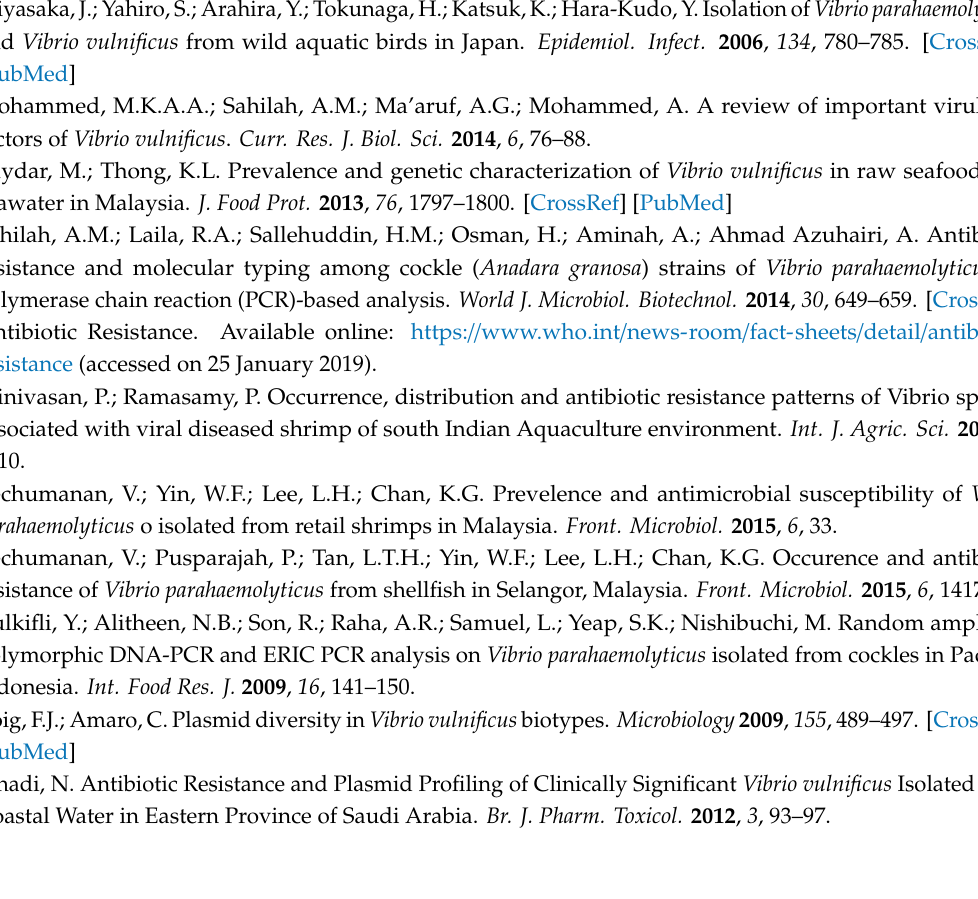
Figure S1: Plasmid identification using PureYield ™ Plasmid Miniprep System kit (Promega, USA) on 1% (w / v) agarose gel. Lane 1: Lambda. DNA-HindIII Digest DNA ladder. Lane 1-15: Vv isolates 1-15; Figure S2: Plasmid identification using PureYield ™ Plasmid Miniprep System kit (Promega, USA) on 1%(w / v) agarose gel. Lane 1: Lambda DNA-HindIII Digest DNA ladder. Lane 2-11: Vv isolates 16-26. Figure S3: Plasmid identification using PureYield ™ Plasmid Miniprep System kit (Promega, USA) on 1%(w / v) agarose gel. Lane 1: Lambda DNA-HindIII Digest DNA ladder. Lane 2- 6 Vv isolates 27-31. Figure S4: Plasmid identification using PureYield ™ Plasmid Miniprep System kit (Promega, USA) on 1%(w / v) agarose gel. Lane 1: Lambda DNA-HindIII Digest DNA ladder. Lane 2-15: Vv isolates from 32 to 46 and lane 16: negative control. Figure S5: Plasmid identification using PureYield ™ Plasmid Miniprep Systemkit (Promega, USA) on 1%(w / v) agarose gel. Lane M: Lambda DNA-HindIII Digest DNA ladder. Lane 2-15: Vv iolates from 47 to 60 and lane 16 NC: negative control. Table S1: Antibiotic resistance among Vibrio vulnificus isolates; Table S2: Antibiotic resistance among Vibrio vulnificus